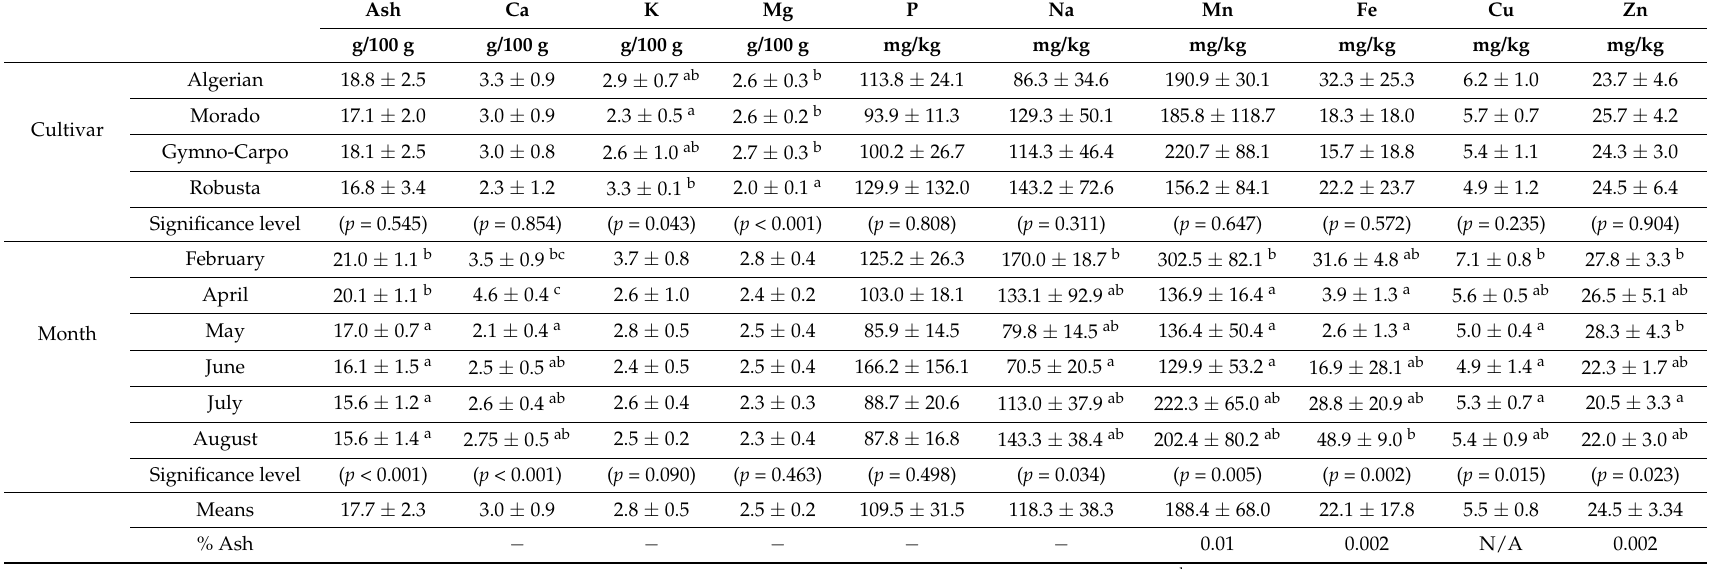
Table 3. Micronutrient content of freeze-dried mucilage powders extracted from four cactus pear cultivars harvested from cladodes over six